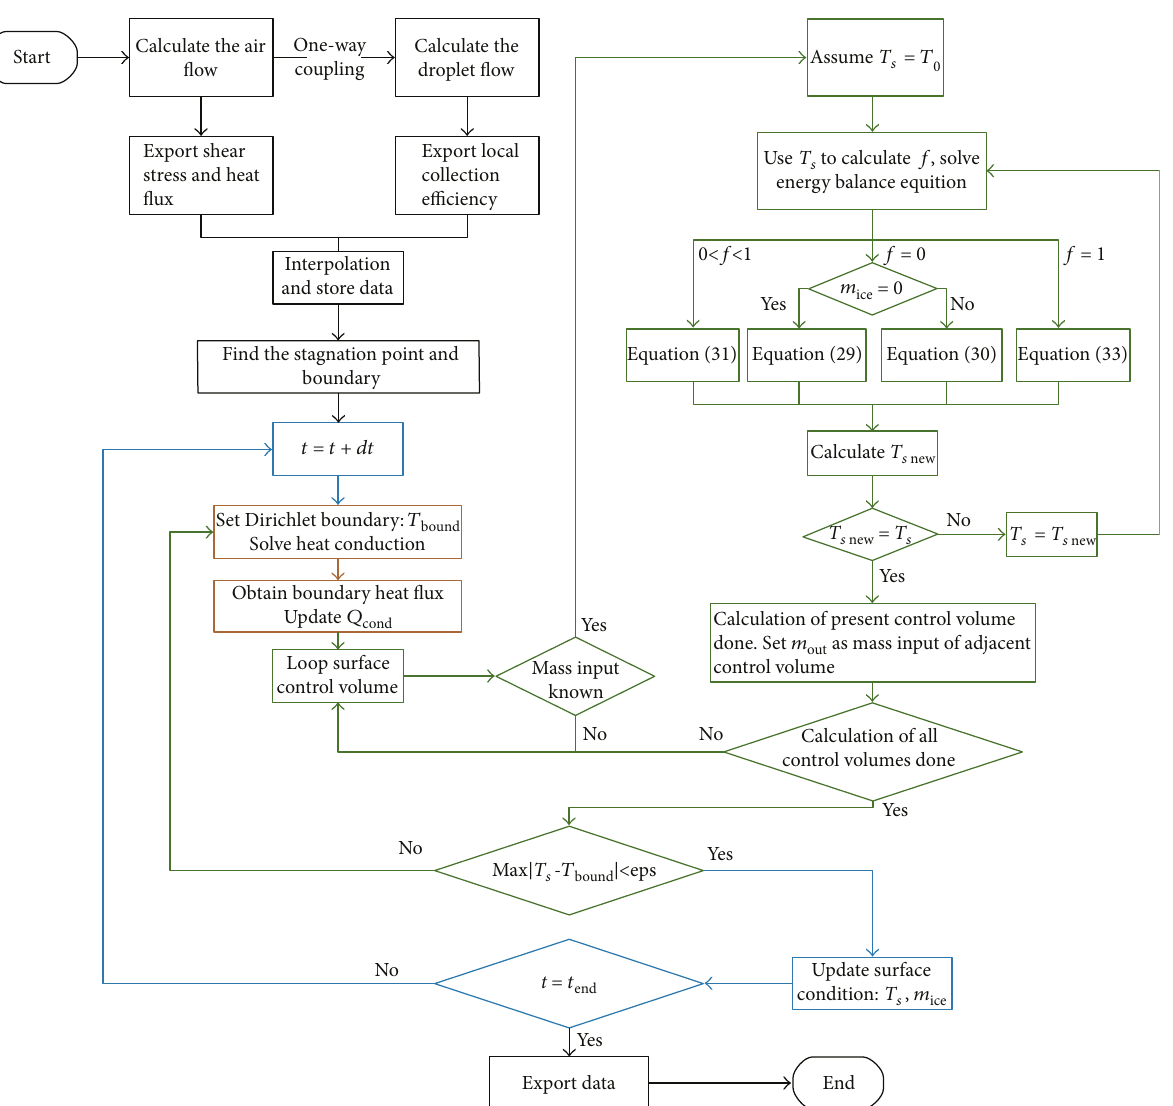
Figure 3: Flowchart of solution procedure.